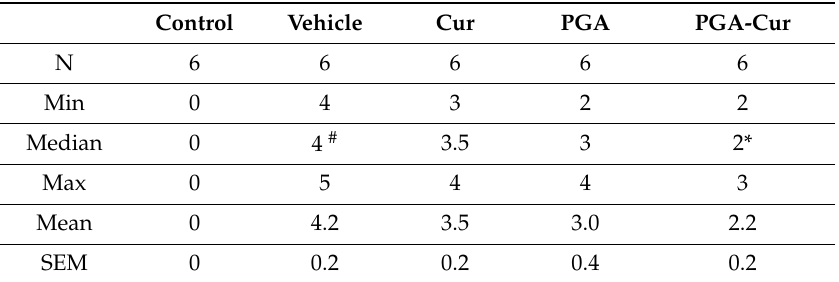
Table 2. The e ff ect of PGA and curcumin (Cur) given individually or in a co-micronized formulation (PGA-Cur) on the severity of the histological inflammatory score in carrageenan-injected paw. The score was a 6-point scale, from 0 (no inflammation) to 5 (severe inflammation) [43]. Control